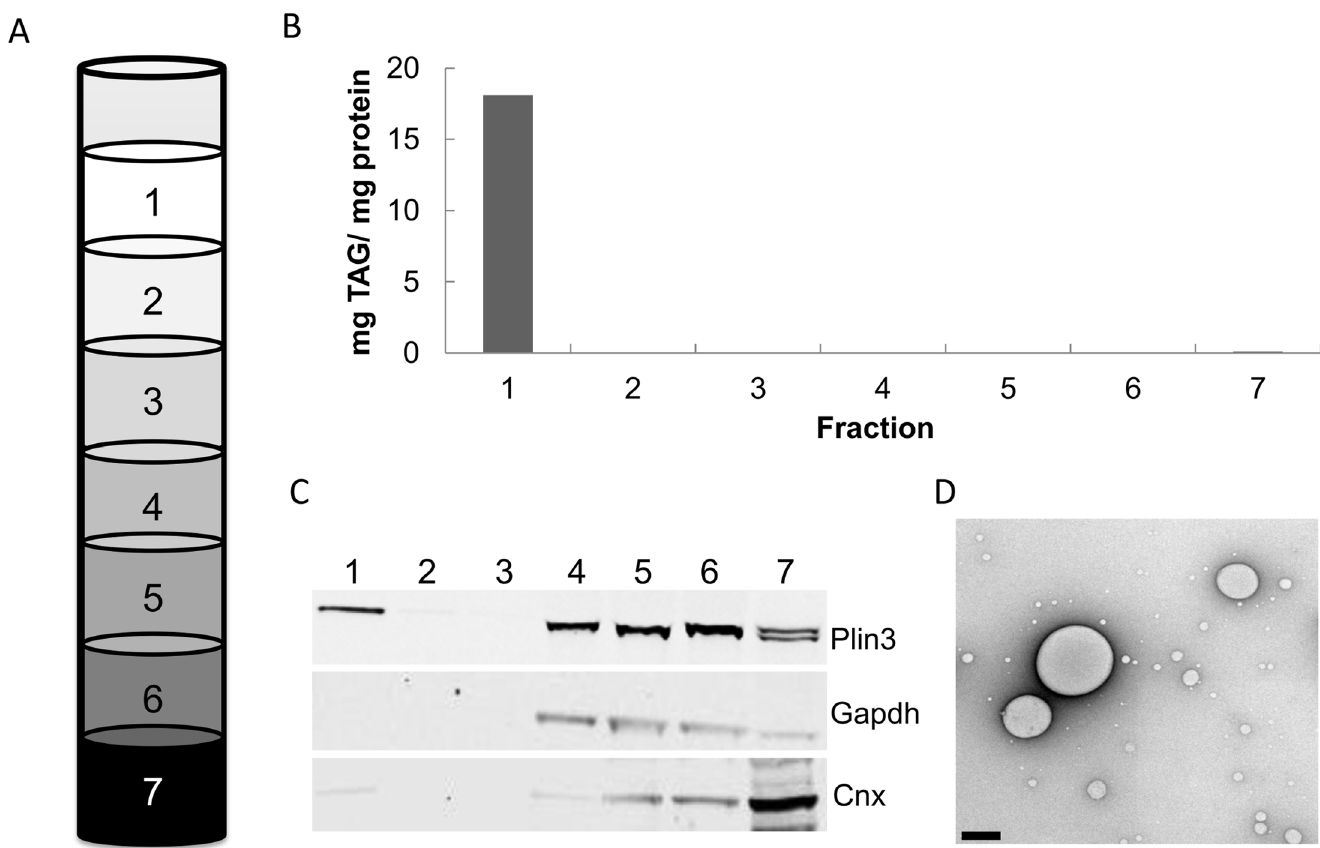
Fig 2. Isolated CLD fraction is enriched with CLD marker, Plin3, and has a high TAG to protein ratio. Enterocytes were isolated from the jejunum section of mouse small intestine, two hours after a 200 μ l olive oil bolus. (A) Cells were lysed and fractionated using sucrose gradient ultracentrifugation. After freezing, the sample was cut into 7 fractions. (B) TAG/ protein ratio of isolated fractions. (C) Immunoblot analysis of the fractions with known markers of CLDs (Plin3), cytosol (Gapdh), and membranes (Cnx). (D) Negative staining transmission electron micrograph of fraction 1. Scale bar, 0.5 μ